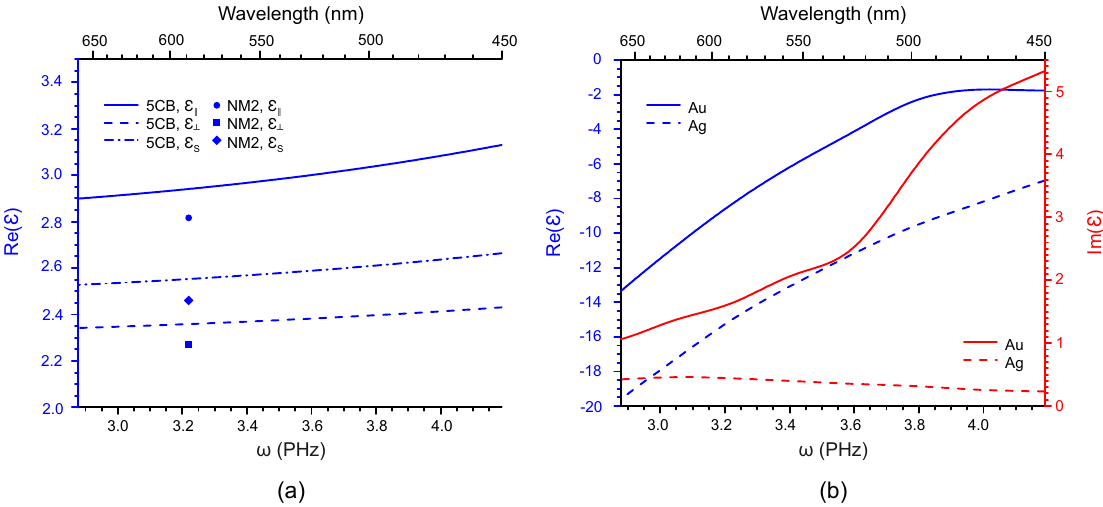
Figure A1. Frequency dependence of the components of the dielectric susceptibility of the nematic hosts 5 CB [25] and NM 2 [26] ( a ) and gold and silver ( b )